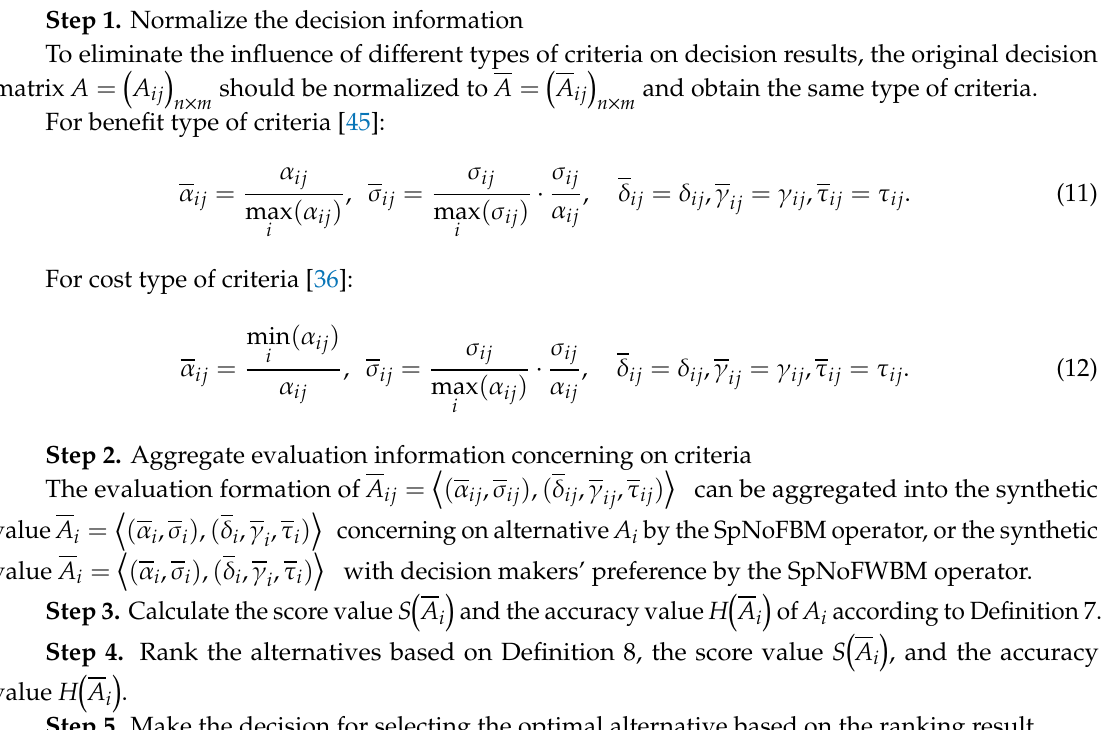
Figure 1. The procedure of the proposed